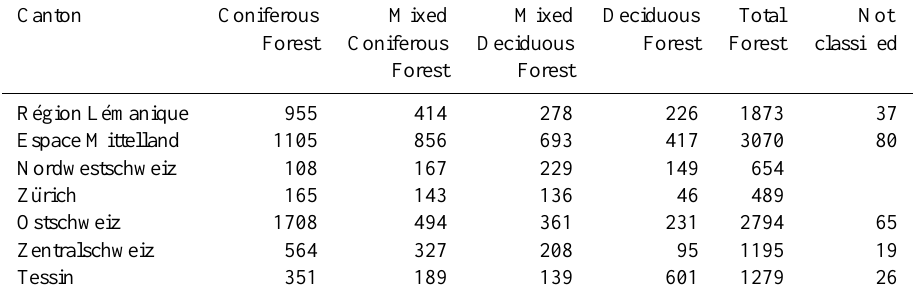
Table 4. Statistical distribution of coniferous and deciduous forest [km 2 ] for each Swiss canton (Swiss Federal Statistical Office, 2004).